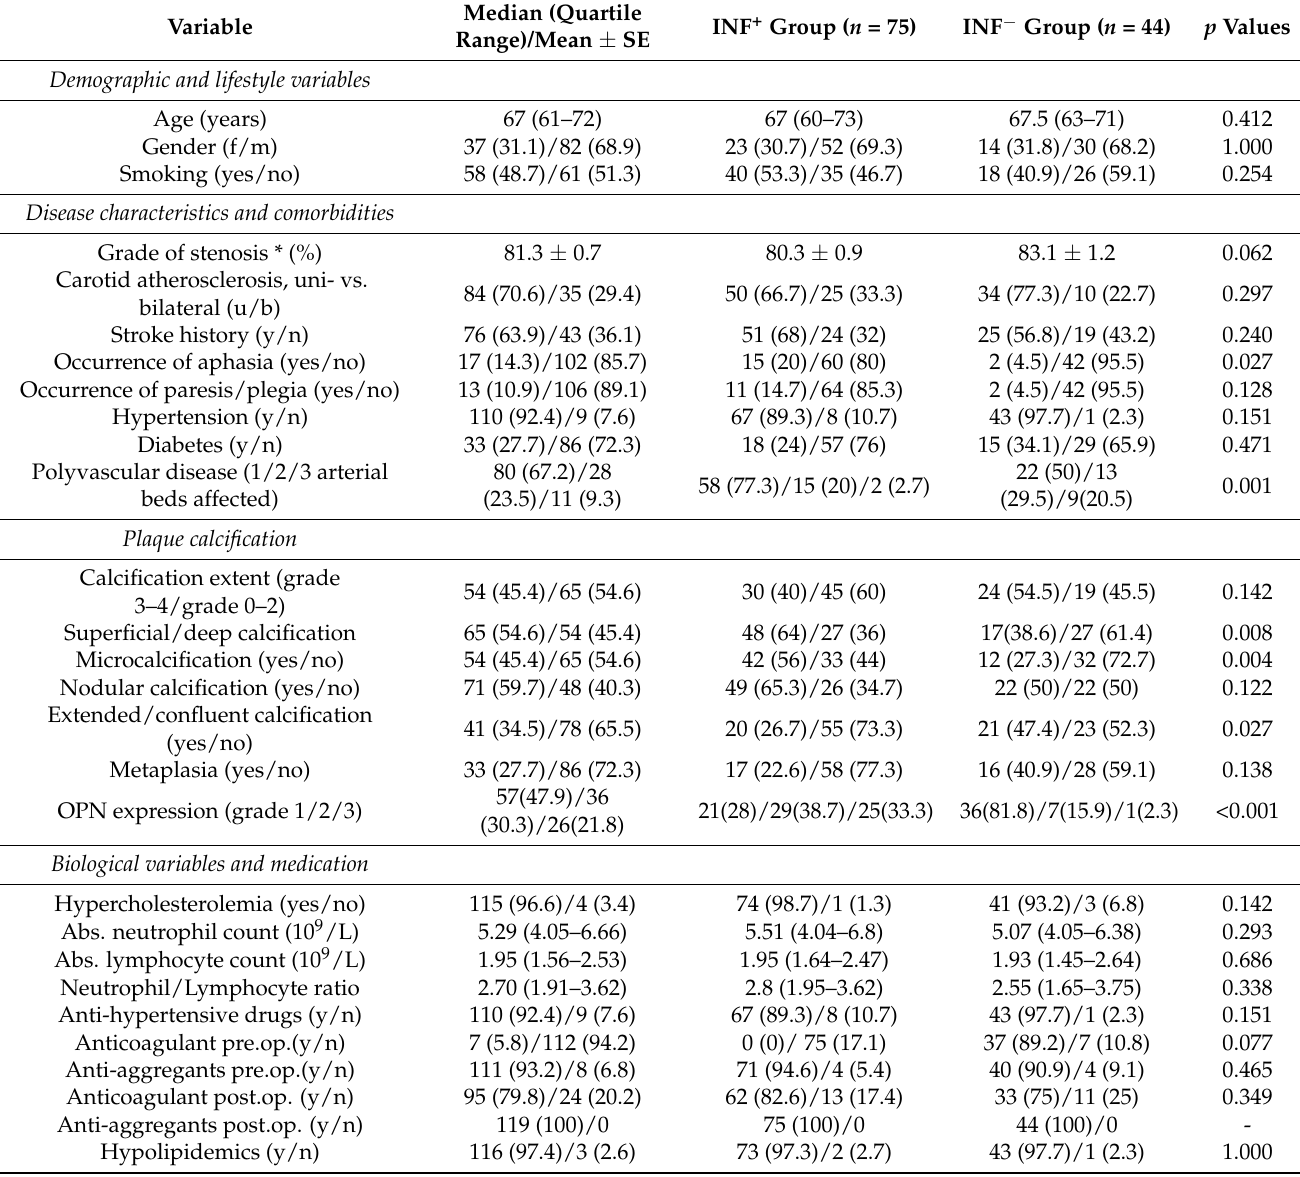
Table 1. Clinical variables of the 119 atheromatous plaques, with vs. without inflammatory